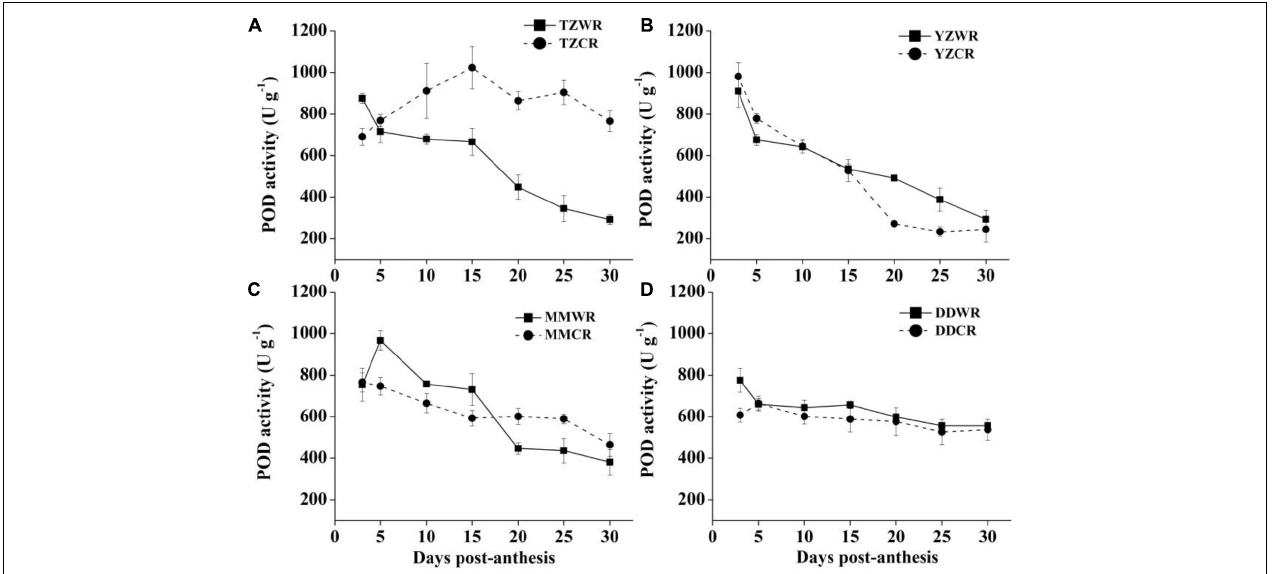
FIGURE 7 | Changes in activities of POD in weedy rice and cultivated rice. (A) Weedy and cultivated rice from Taizhou; (B) weedy and cultivated rice from Yangzhou; (C) weedy and cultivated rice from Maoming; (D) weedy and cultivated rice from Dandong. TZWR, weedy rice from Taizhou; TZCR, cultivated rice from Taizhou; YZWR, weedy rice from Yangzhou; YZCR, cultivated rice from Yangzhou; MMWR, weedy rice from Maoming; MMCR, cultivated rice from Maoming; DDWR, weedy rice from Dandong; DDCR, cultivated rice from Dandong. Solid line represents weedy rice and dash line represents cultivated rice. The data are presented as mean ± SE ( n =